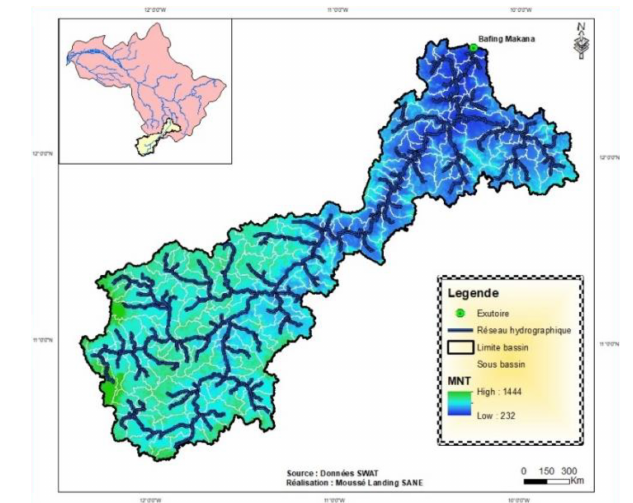
Figure 1. Bassin versant du Bafing Versant en amont de Bafing-